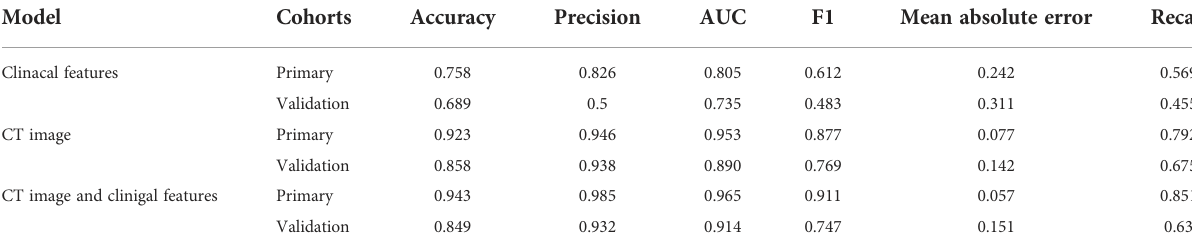
TABLE 5 Predictive performance of SVM in the primary and validation cohorts.